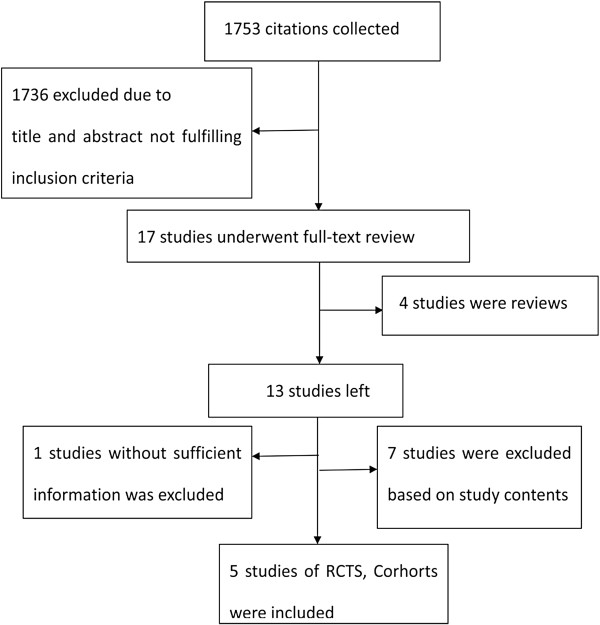
Results of literature search.